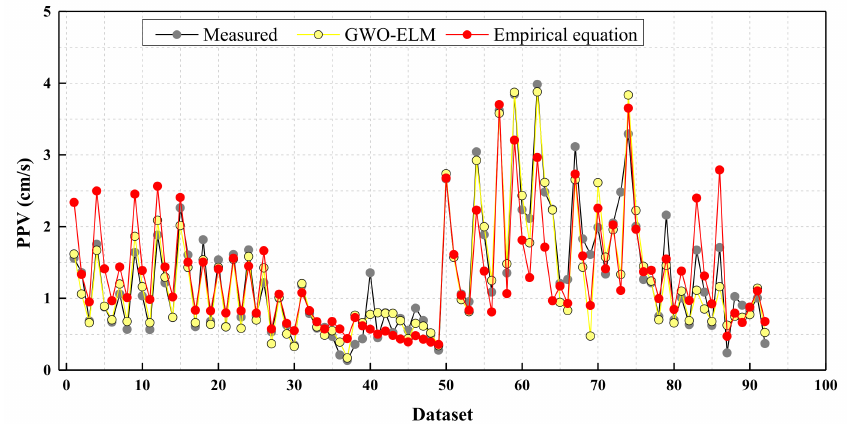
Figure 14. Performance differences in PPV